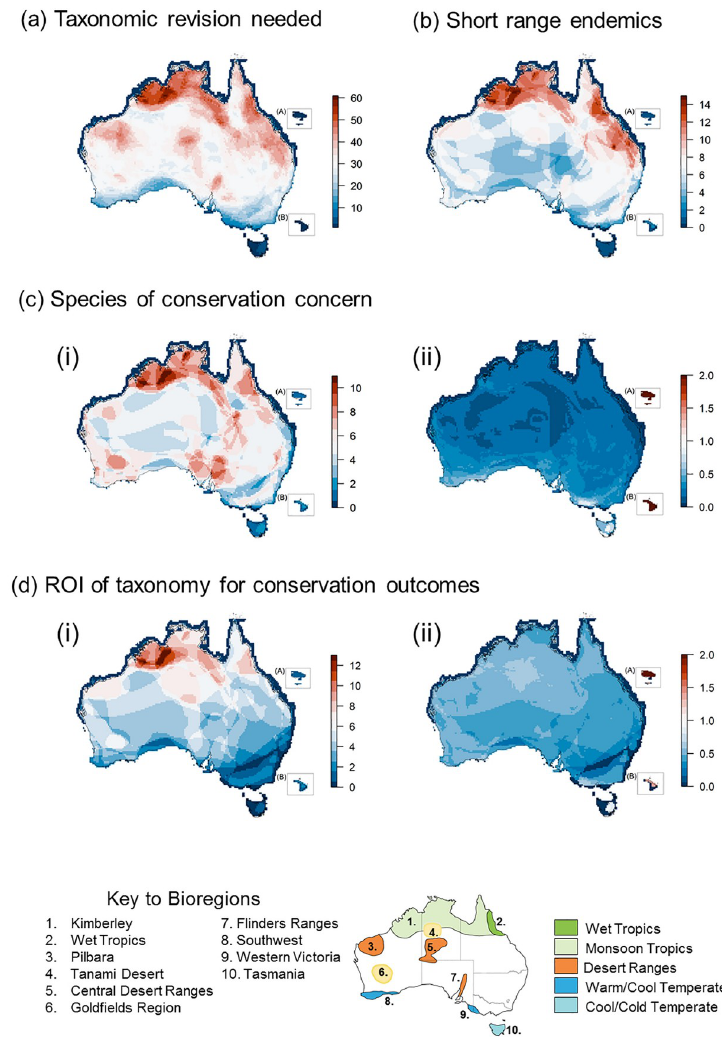
Fig 1. Spatial pattern of species richness in Australian lizards and snakes. (a) The distribution of species requiring taxonomic revision that would result in an increase in species. (b) Species requiring taxonomic revision that contain undescribed highly localized species. (c) Species requiring taxonomic revision that contain species of conservation concern. (d) Priority species ( N = 24 identified using a return-on-investment (ROI) analysis. Maps (a) and (b) present the sum of species contained in each 25 × 25 km cell. For the last 2 criteria— (c) and (d) —data are mapped in 2 ways: (i) sum of species in cells and (ii) weighted mean. The weighted mean ROI for map cells are square root transformed, due to significant influence of extreme values. Scale for each map indicates range of cell scores. Insets (not to same scale) show Norfolk Island group (A) and Lord Howe Island group (B). A key to bioregions is provided below maps, with regions referred to in text numbered. Assessment data presented in maps available in S1 Data and distributional data used for mapping was collated by Tingley and colleagues [19] and is publicly available from the IUCN website (https://www.iucnredlist.org/). Map layer: Bioregional Assessment Source Dataset (https://data.gov.au/data/dataset/ 0cb242e2-daed-4507-a42e-73892c0941a1).